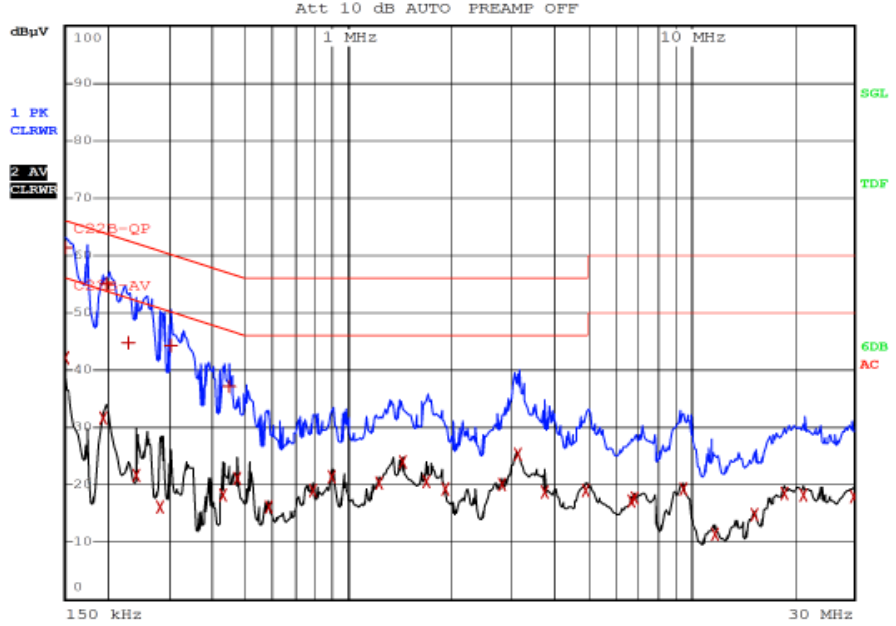
Figure 12. Conducted Emission for EUT—Phase: average values—black waveform, quasi-peak values—blue waveform.